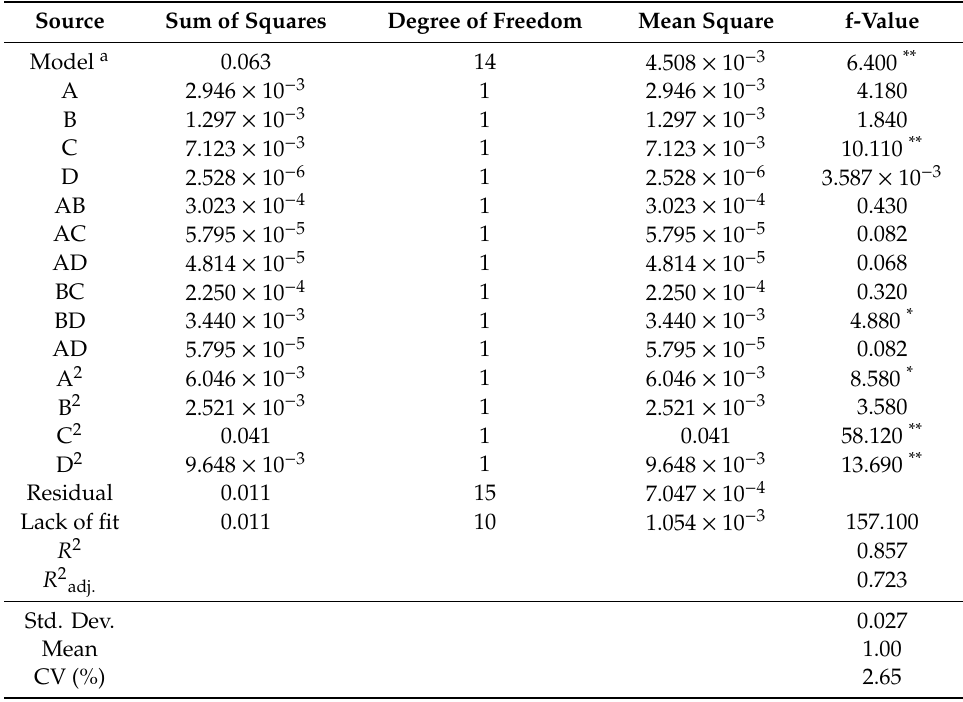
Table 1. Analysis of variance and significance test.